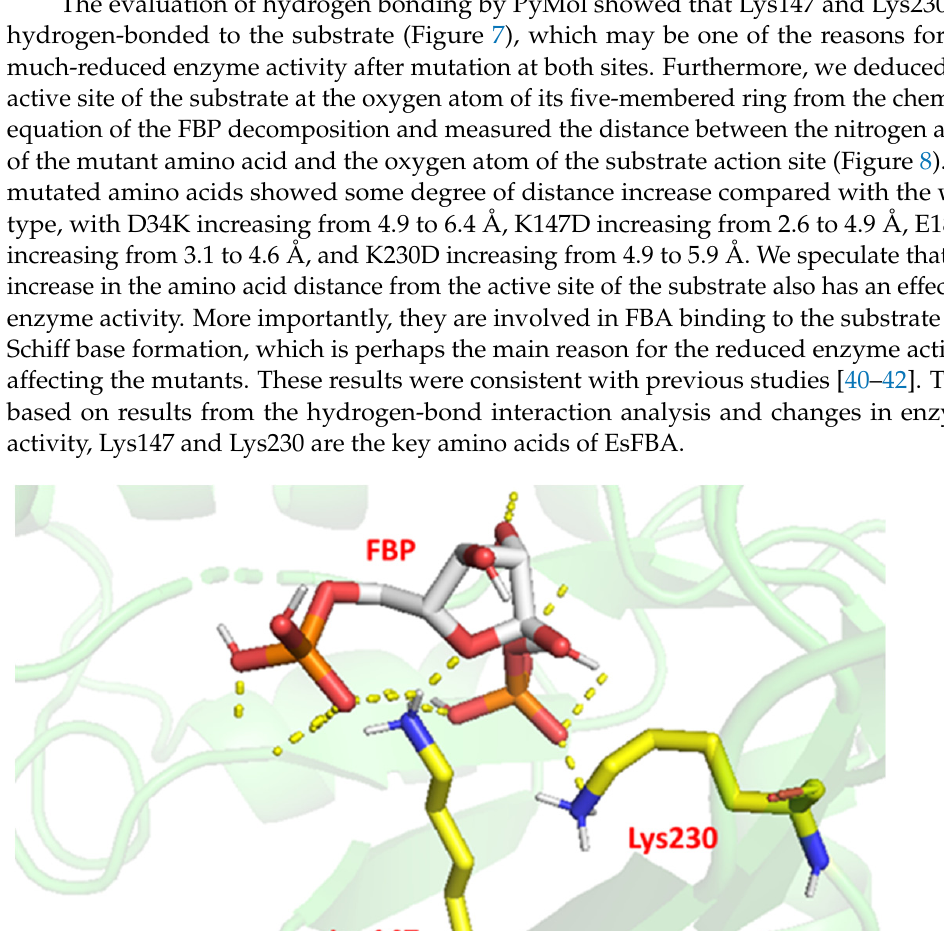
Figure 8. Diagram showing the interaction between mutated or wild-type amino acids with the sub- strate. ( a ) D34K, ( b ) K147D, ( c ) E188H, and ( d ) K230D. 3. Materials and Methods 3.1. Materials and Instruments E. superba samples were kindly provided by the Liao Yu Group, who captured the samples in Antarctic waters in October 2019 and cryopreserved them at − 80 °C until use. All chemicals were purchased from Sinopharm Reagent Co., Ltd. (Shanghai, China), Shanghai Sangon Biology Co., Ltd. (Shanghai, China), Dalian Takara Co., Ltd. (Dalian, China), and British OXOID Co., Ltd. (Basingstoke, UK) and used without further purifi- cation. Mettler Toledo S20 pH meter (Mettler Toledo, Greifensee, Switzerland), HH-1 elec- tric constant temperature water bath (Changzhou Guohua, Changzhou, China), CR21GII